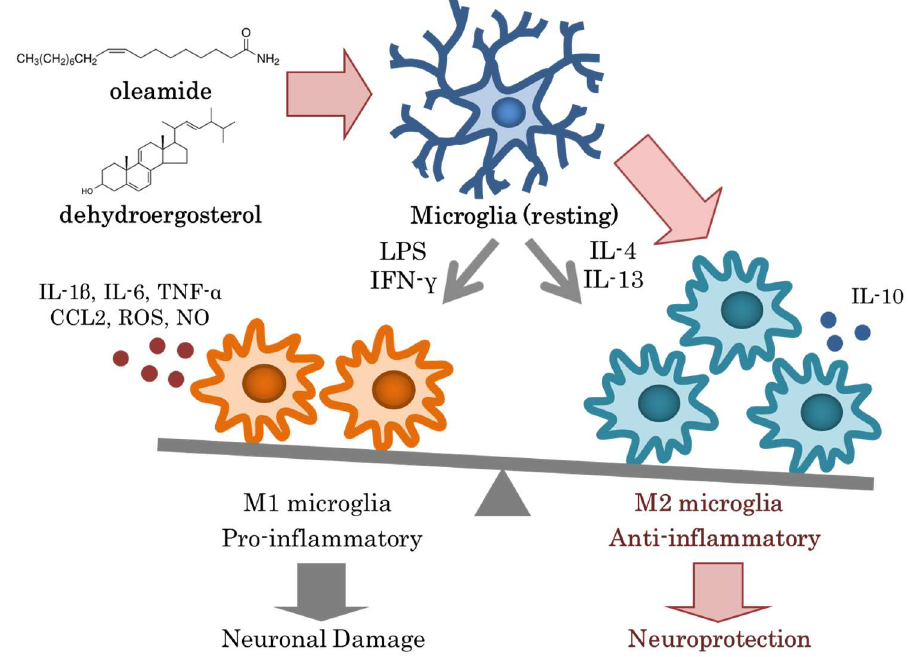
Figure 1. Modulation of microglial activation by dairy products.